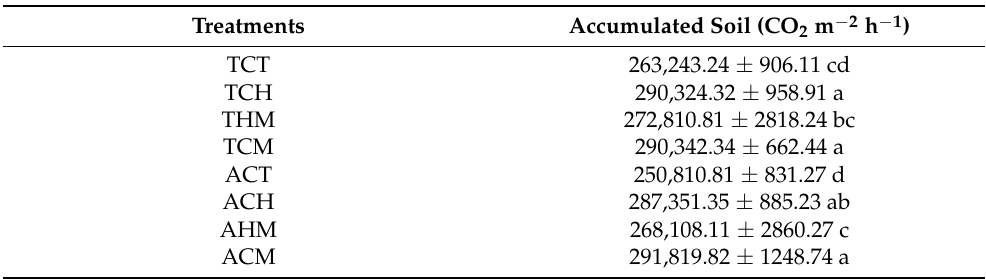
Table 5. Accumulated soil CO 2 emissions for all treatments during the maize cropping period, for the 8 managements (average ± SD).